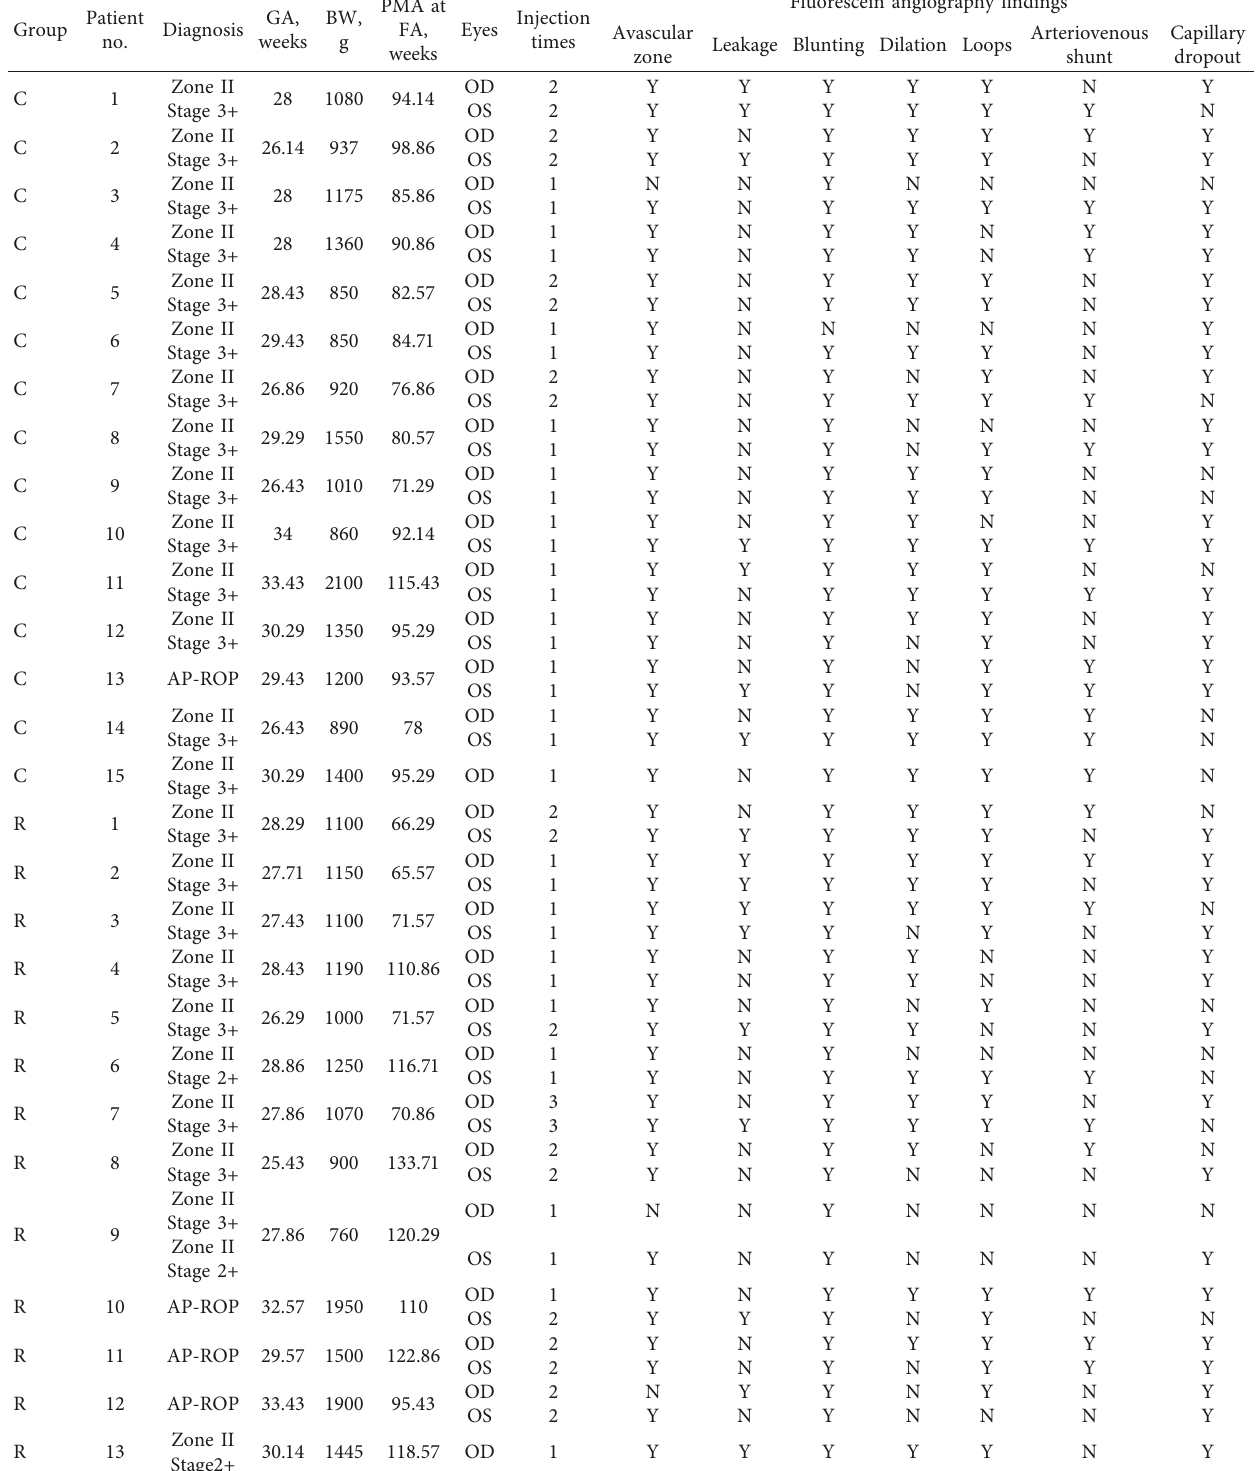
Table 2: Fluorescein angiographic findings after primary intravitreal conbercept or ranibizumab in neonates with ROP. Patient Group